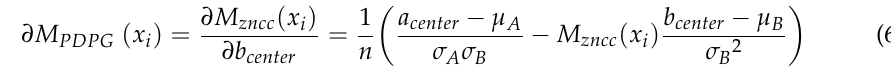
Figure 2. Schematic diagram of the minimization of ZNCC error. A and B are two image patches from the reference and predicted images at x i . The black lines indicate that the two image patches are combined to calculate the ZNCC value. The arrows represent the differential of ZNCC with respect to the pixels in B. The right part of Figure 2 shows that ZNCC is jointly calculated by a m and b m . To minimize the ZNCC error, the partial differential only changes the center pixel, while the total differential changes all the pixels in B